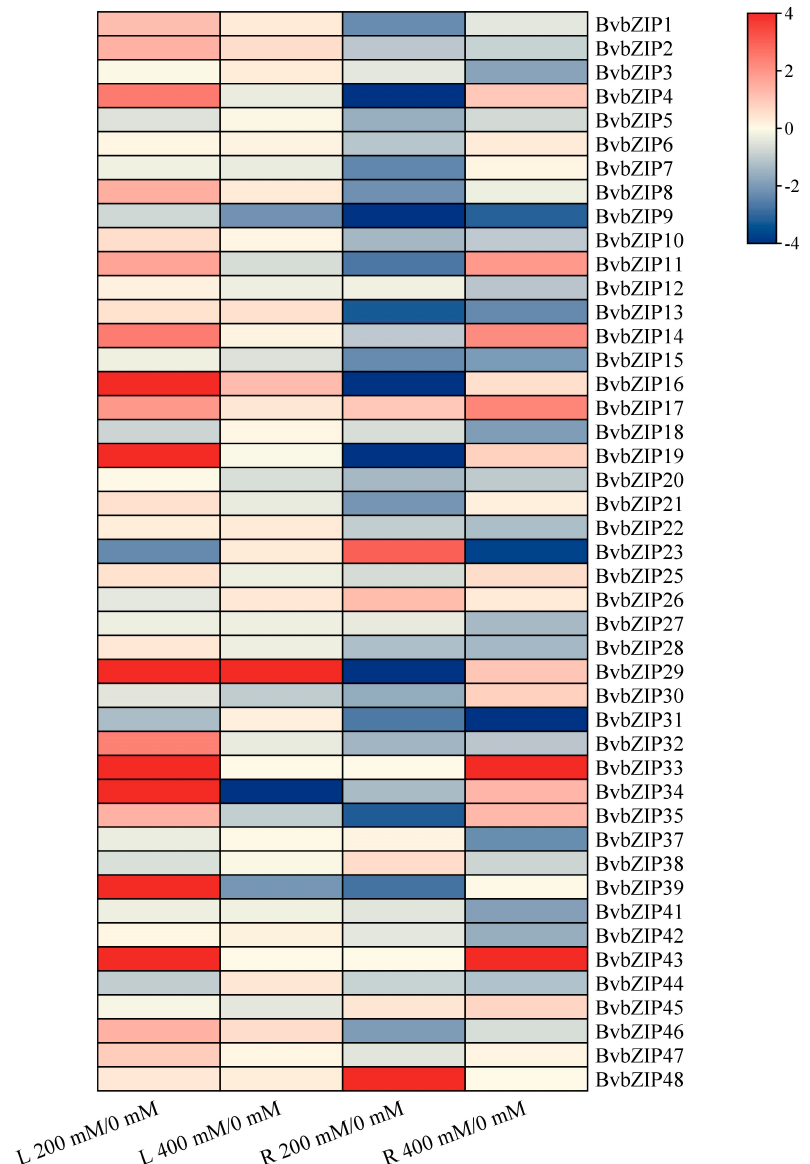
Figure 8. Analysis of expression patterns of the BvbZIP genes under salt stress. L indicates leaf tissue, R is root tissue, 0, 200 and 400 mM are different concentrations of NaCl treatment, and the expression pattern of BvbZIP genes is reflected by the logarithm of expression ratio under different concentrations of NaCl treatment. Blue is down-regulated expression, and red is up-regulated